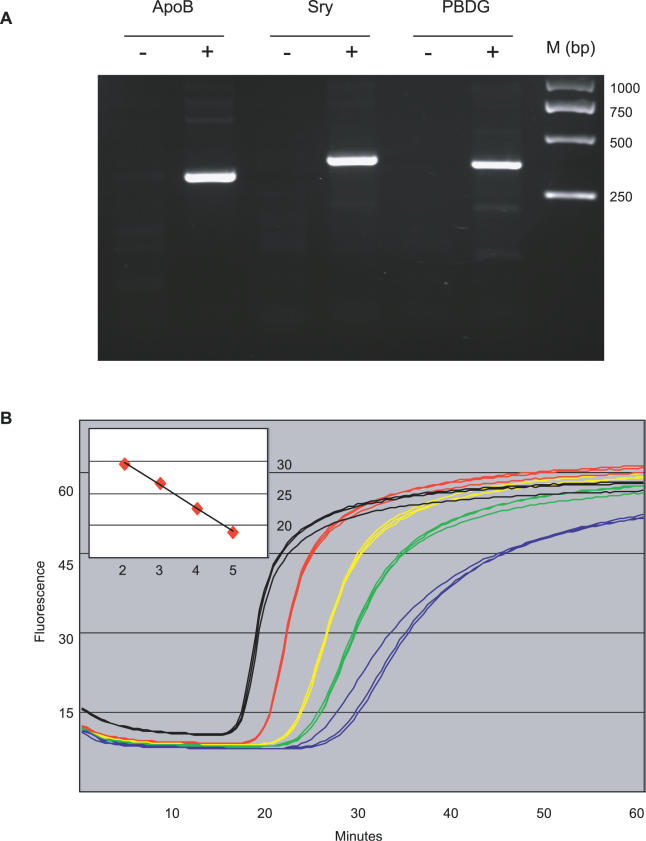
RPA Amplifies Specific Target Regions from Complex DNA Templates in less than 30 Minutes(A) Acrylamide gel electrophoresis of RPA products using primers for three human markers (apoB, Sry, PBDG). Water (−) or 1,000 copies of genomic DNA (+) served as template. Ten percent of each reaction is loaded on the gel. The expected product sizes are 305, 371, and 353 base-pairs for apoB, Sry, and PBDG, respectively.(B) Real-time RPA using primers for the
B. subtilis SpoB locus. Fluorescence upon intercalation of SybrGreenI into nascent product is detected.
B. subtilis DNA served as template in triplicate reactions at 10
5 (black), 10
4 (red), 10
3 (yellow), or 100 copies (green) or water (blue). The onset of amplification depends linearly on the logarithm of the starting template copy number [see inset; time in minutes (midpoint of growth curve) versus log {template concentration in copy number)].